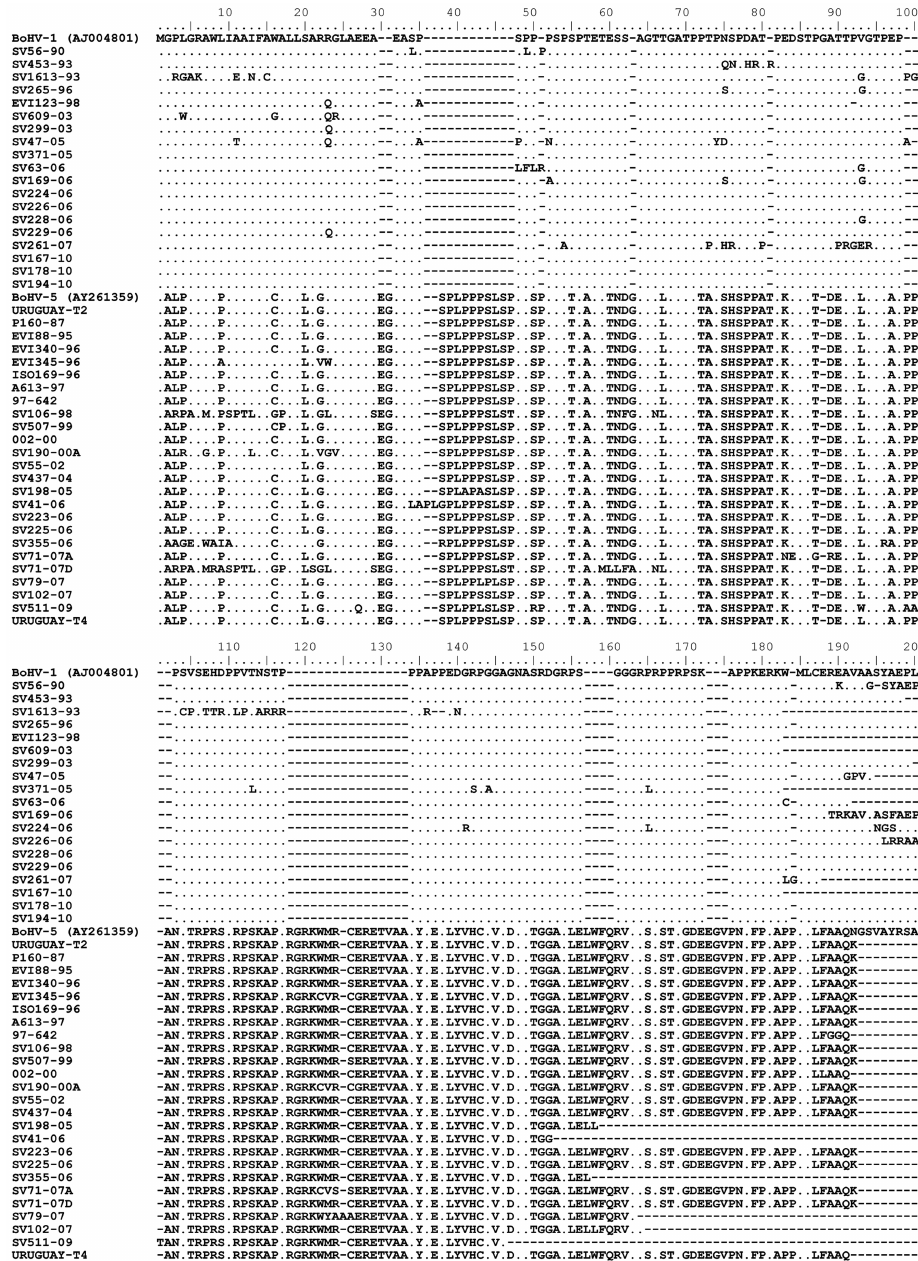
Figure 1. Deduced amino acid sequence alignment of the 5 9 third of glycoprotein C gene of bovine herpesvirus 1 (BoHV-1, n=19) and BoHV-5 (n=25). Reference sequences of BoHV-1 and BoHV-5 (GenBank ID AJ004801 and AY261359) are included for